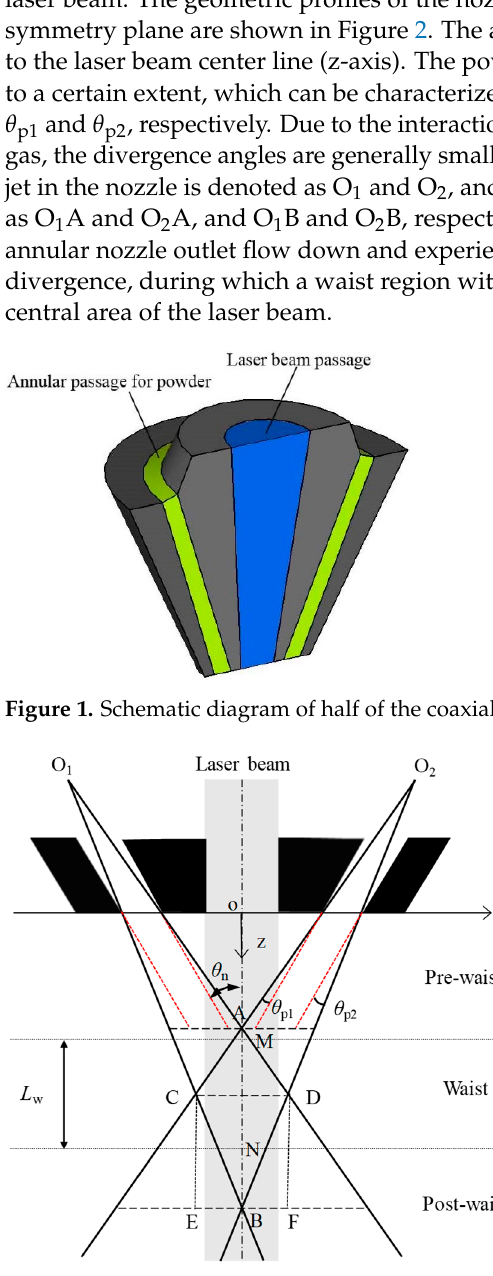
Figure 2. Geometric profile of the powder stream.